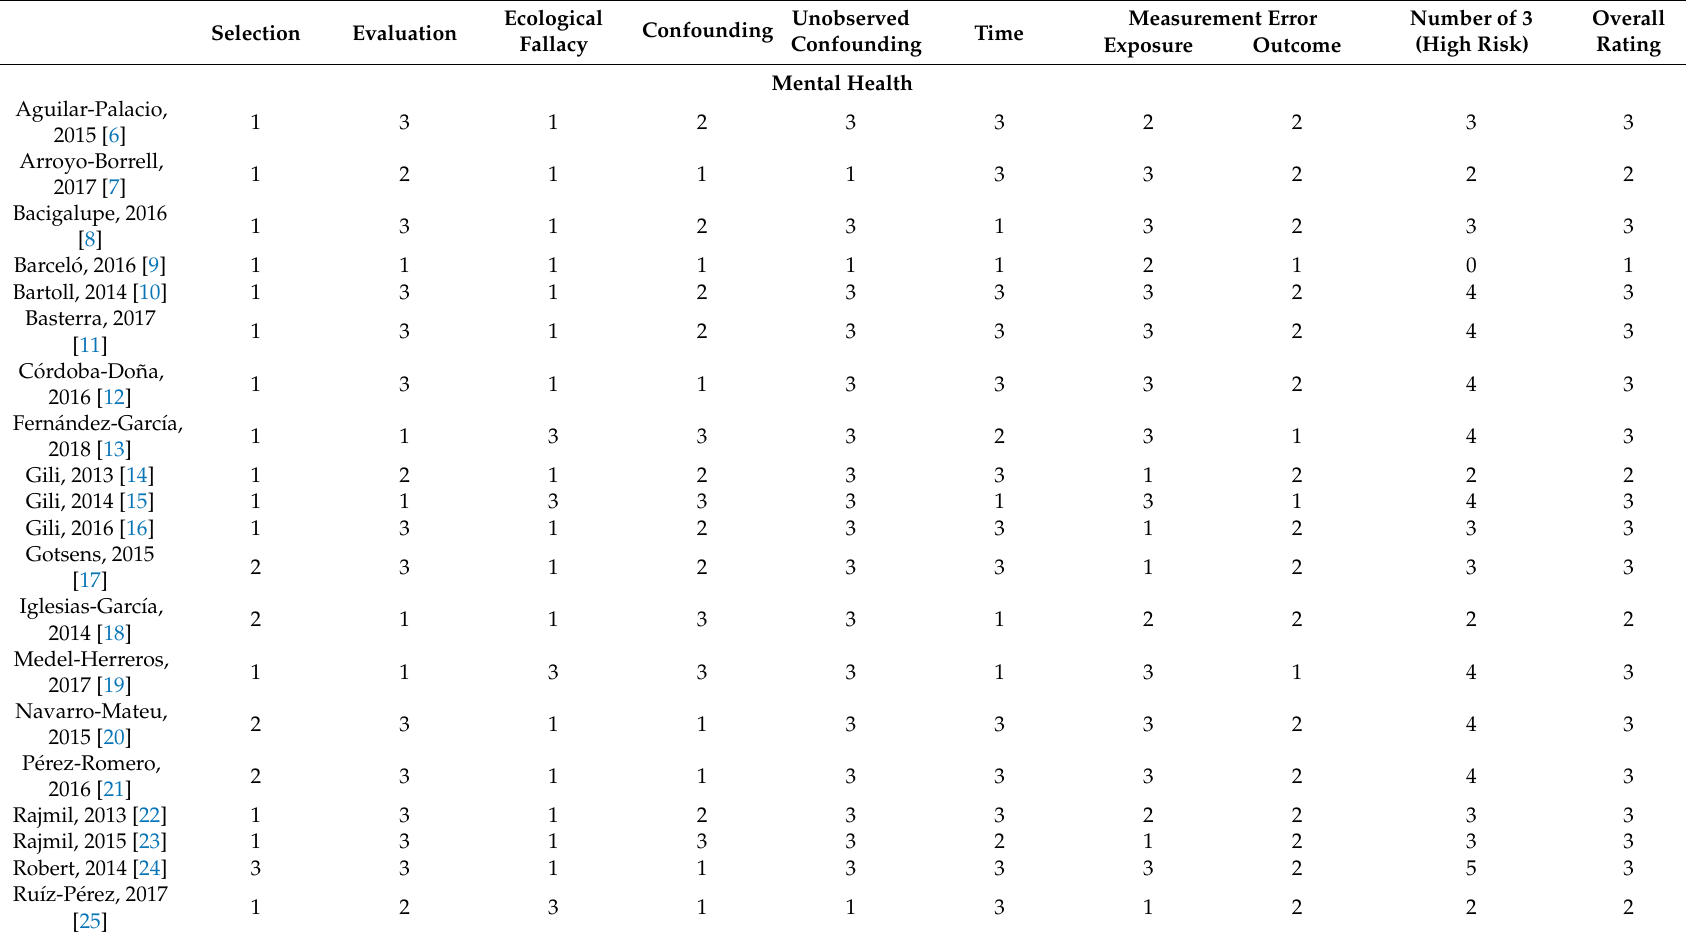
Table 2. Evaluation of bias for the 53 studies in the systematic